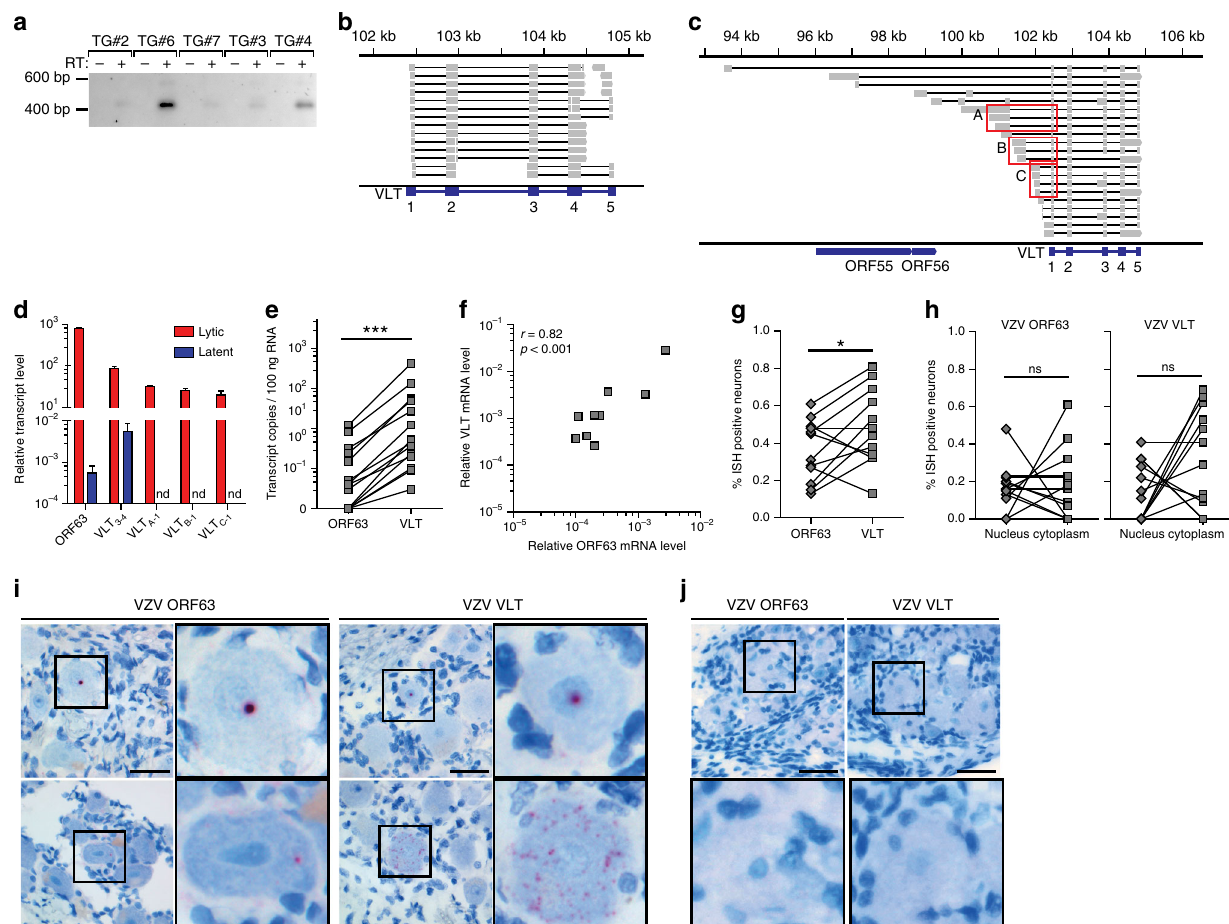
Fig. 4 Prevalence of VLT and ORF63 transcript in human TG. a PCR ampli fi cation of cDNA ( n = 5 TGs, Supplementary Table 1), synthesized in the presence ( + ) or absence ( − ) of reverse transcriptase. Sanger sequencing of all fi ve puri fi ed PCR products yielded identical sequences corresponding to VLT (Fig. 3b). b Integrative Genomics Viewer (IGV) screenshot showing representative RNA-Seq data from a single TG. Paired-end reads are shown as fragments mapped across the VLT locus. Grey boxes (exons) connected by black lines (introns) indicate individual read pairs with distinct read-pairs separated by white space. Each fragment spans between 2 and 5 exons and there was no evidence of additional upstream exons. c In lytically VZV-infected MeWo cells, Sanger sequencing of amplicons generated through rapid ampli fi cation of cDNA ends revealed multiple VLT ly isoforms, visualized using IGV. Sequencing of 29 clones identi fi ed the three most abundant VLT ly isoform groups (red boxes) A (35%), B (19%) and C (15%). Note that the speci fi c VLT isoform observed in latently infected TG was not observed among VLT ly isoforms. d Quanti fi cation of ORF63 transcript and VLT isoforms in lytically VZV- infected ARPE-19 cells (red; n = 3) and latently VZV-infected TG (blue; n = 19 TG), using primers/probes spanning VLT splice junctions between exons 3 → 4, A → 1, B → 1 and C → 1 (Fig. 4c and Supplementary Table 5). Data represent mean (±SEM) relative transcript levels normalized to β -actin RNA. nd not detected. e Levels of paired ORF63 transcript and VLT (primers/probe spanning exon 2 → 3) in the same VZV POS TG (VZV POS ; n = 15) determined by RT- qPCR. *** p < 0.001; Wilcoxon signed rank test. f Correlations (Spearman) between relative ORF63 transcript and VLT levels in VZV POS TG ( n = 15), as determined by RT-qPCR. g – j In situ hybridization (ISH; red signal) analysis of ORF63 RNA and VLT in latently VZV-infected TG ( n = 12). g Frequency of neurons positive for ORF63 RNA and VLT in consecutive TG sections of the same donor. * p < 0.05; paired Student ’ s t -test. h Nuclear and cytoplasmic ORF63 RNA and VLT expression in consecutive TG sections from individual donors. ns not signi fi cant; paired Student's t -test. i , j Representative ISH images of VZV POS TG sections ( i ) and two VZV naive human fetal dorsal root ganglia ( j ). Nuclei were stained with haematoxylin. Magni fi cation: ×400 (with 3× digital zoom for insets). Bars = 50 µ cultures, 18 cycles for RNA obtained from TGs). Libraries generated from VZV- polyadenylated mRNA (captured by oligo-dT beads, as described by the SureSelect and HSV-1-infected ARPE-19 cells were multiplexed and sequenced using a 75 XT protocol) or underwent rRNA-depletion using a NEBNext ® rRNA Depletion cycle V2 high-output kit. Subsequently, three TG were multiplexed sequenced Kit [Human/Mouse/Rat] (New England Biolabs) according to the manu- using a 150 cycle V2 mid-output kit followed by a further four TG multiplexed facturer ’ s instructions. Subsequent to either procedure, captured/remaining and sequenced using a 300 cycle V2 high-output kit. The decision to use RNAs were transcribed to produce cDNA. Fragmentation, cDNA second-strand increasing read lengths was informed by the initial discovery of VLT and the synthesis, end repair, A-tailing and adapter ligation were performed as described desire to better characterize intron splicing. in the enrichment protocol. Hybridization was performed using a modi fi ed strategy 50,51 that incorporated custom-designed SureSelect RNA bait sets for both VZV and HSV-1 in the same reaction at reduced concentration (1:10). Bait sets for VZV (Supplementary Data 1) and HSV-1 (Supplementary Data 2) were designed at 12× tiling (i.e., each base position in the genome was covered by 12 distinct 120-mer bait sequences) using custom in-house scripts. Hybridization for 24 h at 65 °C was followed by post-capture washing and optimized PCR- based library indexing (12 cycles for RNA obtained from lytically infected